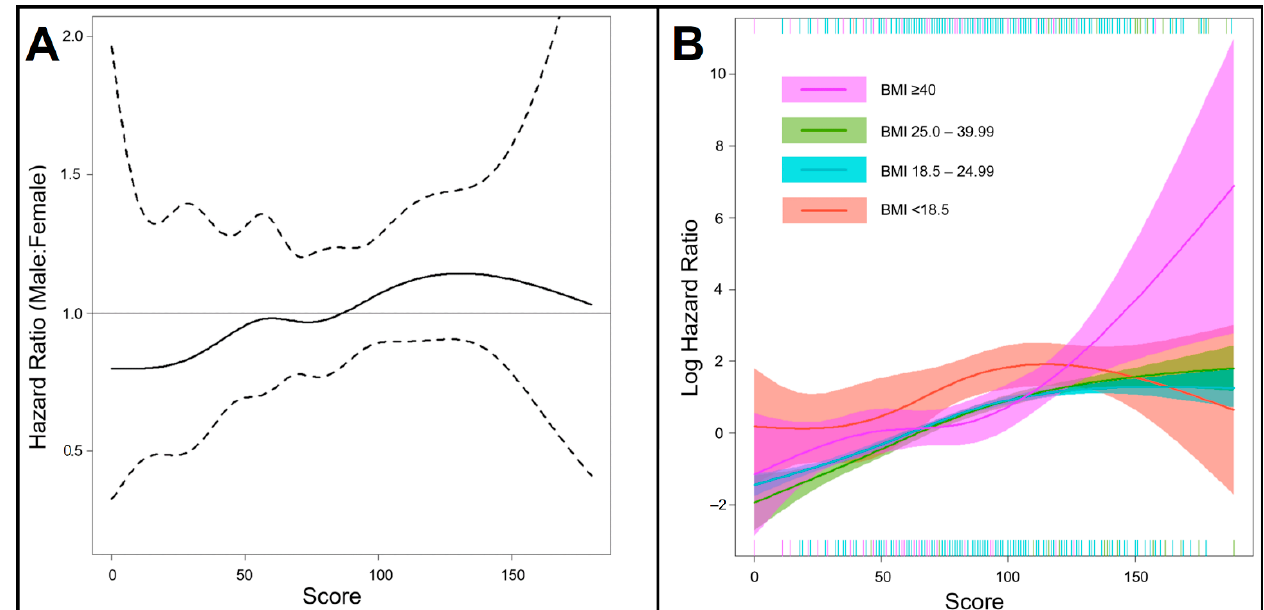
Figure 4. Spline interaction analysis. ( A ) Relationship of the hazard ratio in males relative to females with CABG ‐ BITA across the score. The solid line is the hazard ratio, and the dotted lines are the 95% confidence intervals around the hazard ratio. A hazard ratio of more than 1 suggests increased all ‐ cause mortality in males relative to females, as shown in this figure at higher than 85 points of the score. ( B ) Cross ‐ sectional spline interaction analysis between the score (continuous variable) and the groups of BMI (categorical variable). The solid colored lines represent the log hazard ratios of the BMI categories, and the shadows are shown the corresponding 95% confidence intervals.